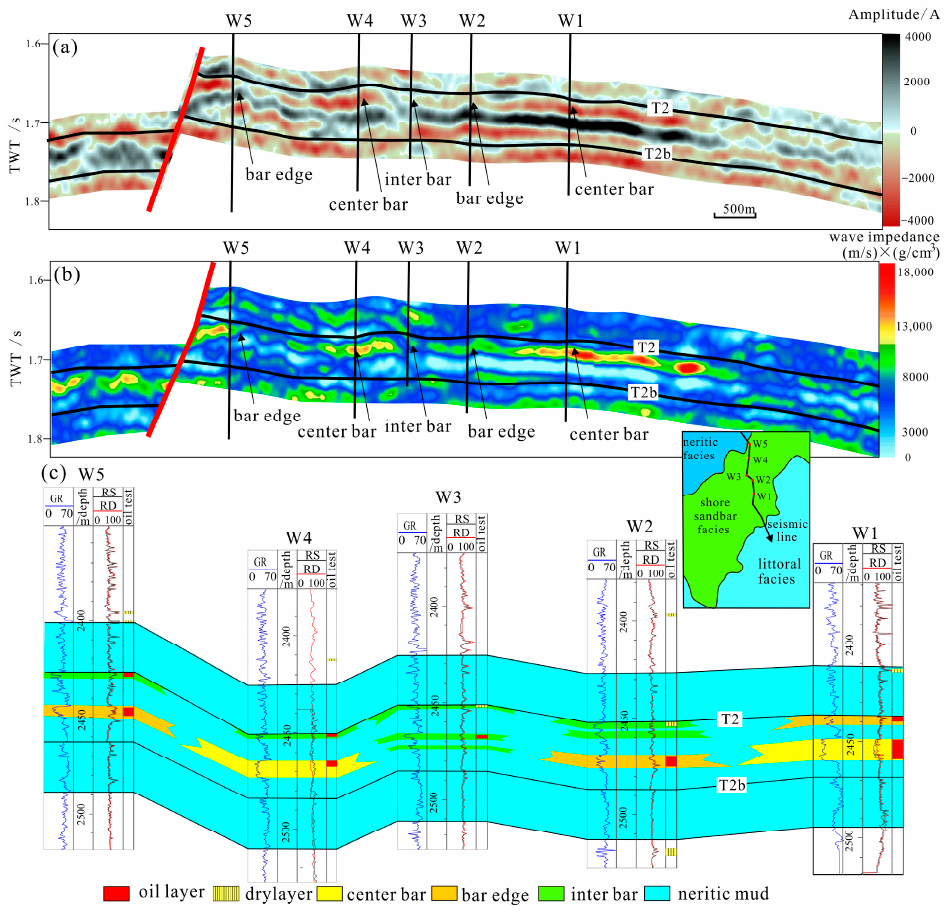
Figure 11. Profile sandbar connectivity analysis map from W1 to W5 well. ( a ) Seismic interpretation profile, ( b ) reservoir inversion profile, ( c ) the inter-well sedimentary facies interpretation profile. The section location is shown in Figure 12.